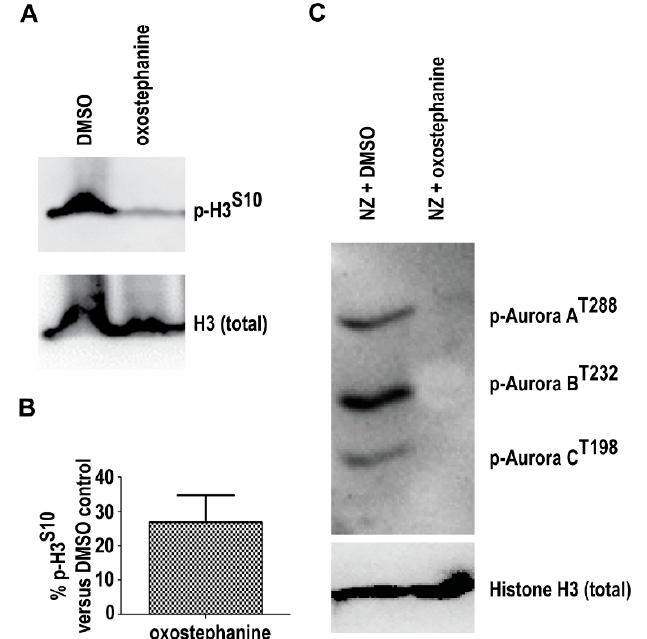
Figure 4. Oxostephanine ( 1 ) inhibits phosphorylation of histone H3 and Aurora kinases A, B and C. ( A ) Histone H3 phosphorylation on Ser-10 (p-H3 S10 ) is substantially downregulated in response to